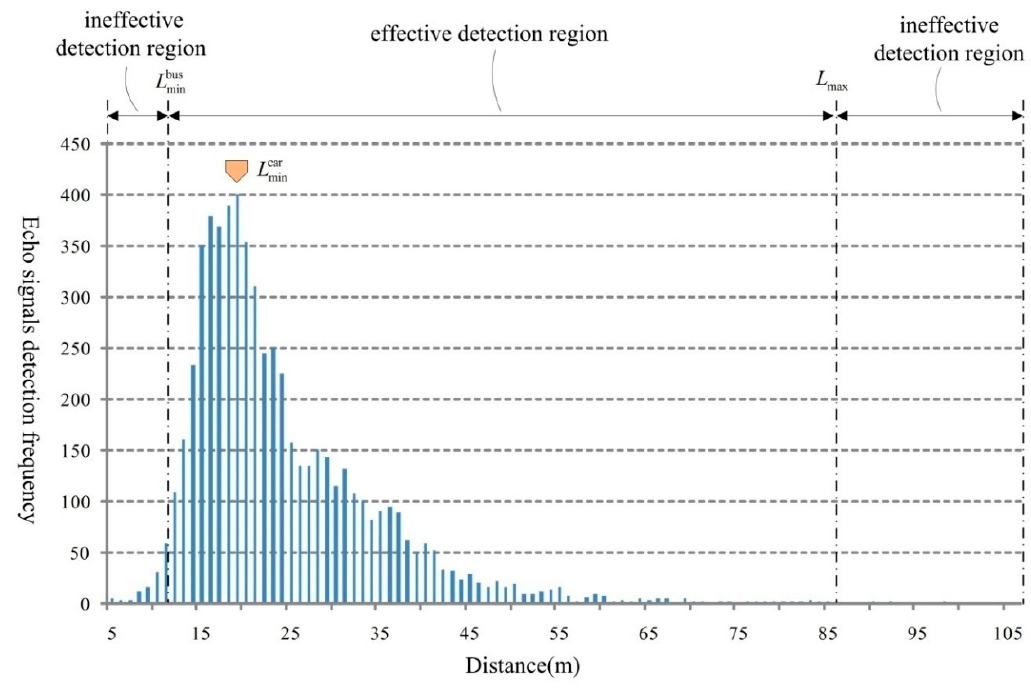
Figure 3. Distribution of the number of times for distance measurement.